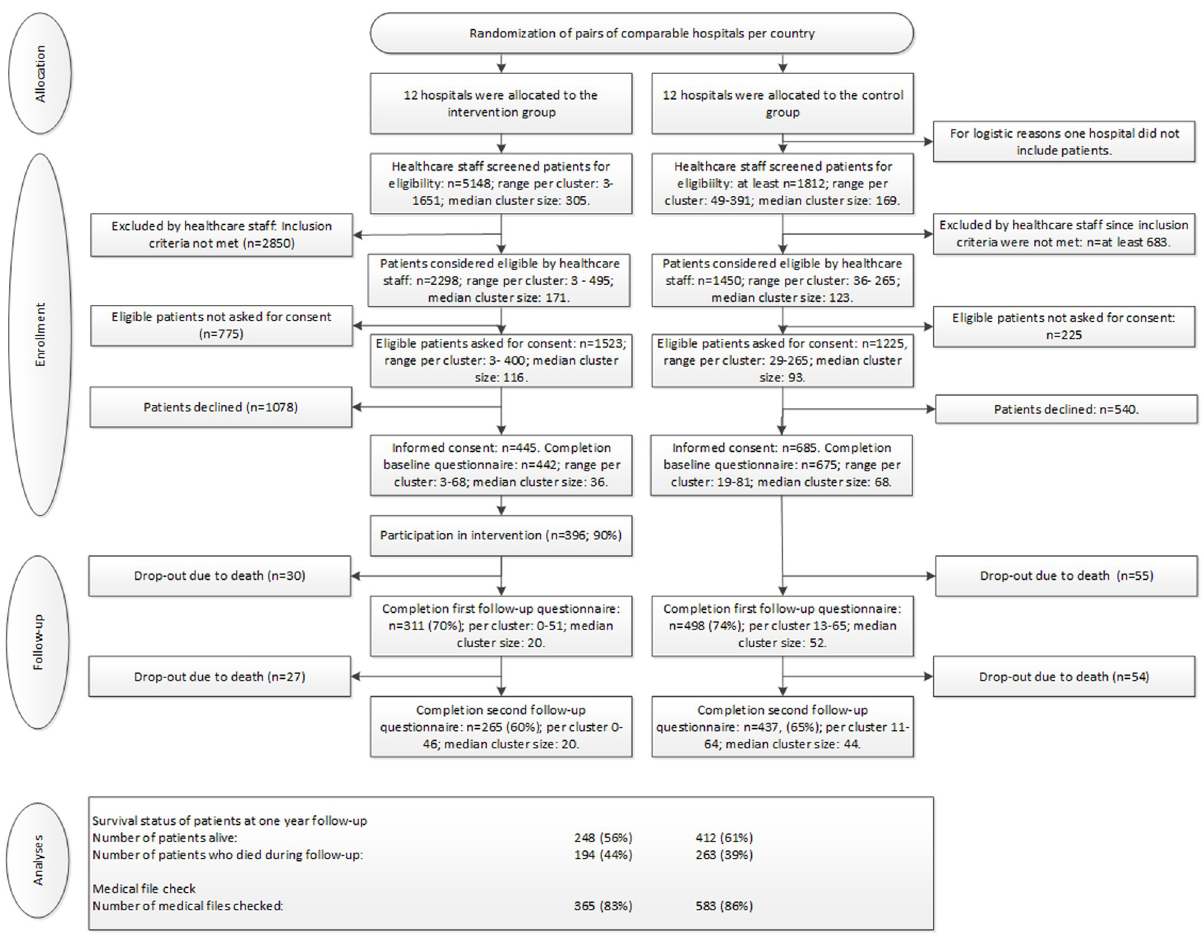
Fig 1. Participant